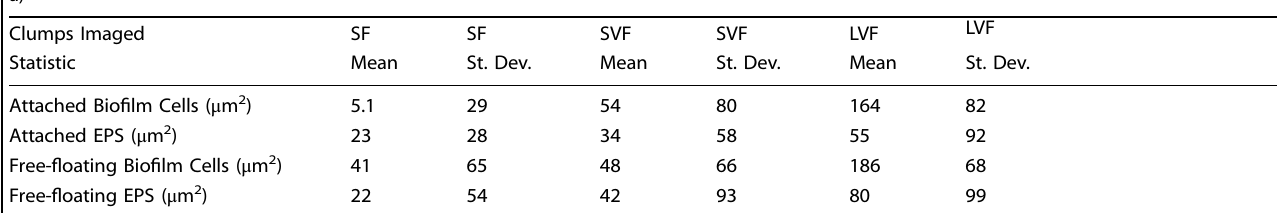
Table 3. The mean and standard deviation of the distribution clumps sizes of stained Bio fi lm Cells and EPS attached to the channel wall and free- fl oating in the ef fl uent.